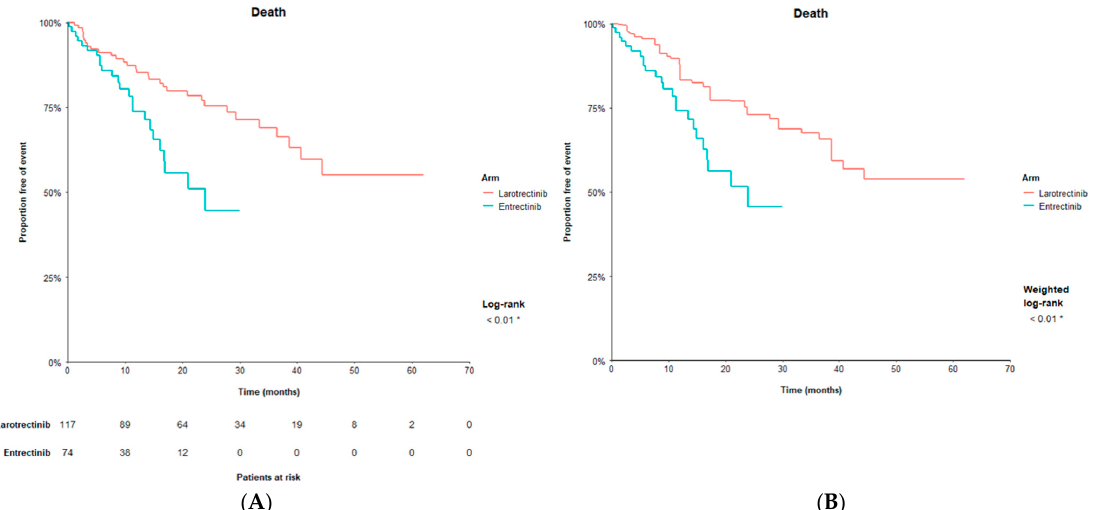
Figure 1. Overall survival with larotrectinib vs. entrectinib. ( A ) Kaplan–Meier curve for overall survival before matching. ( B ) Kaplan–Meier curve for overall survival after matching on primary matching factors a . Notes: a. Primary matching variables include the following: male, age above me-